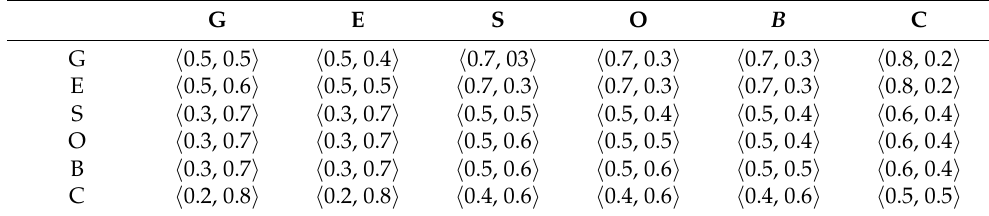
Table 3. Aggregated decision matrix in PF–AHP for the main criteria ( CI = 0.0196675, CR = 0.0158609). G